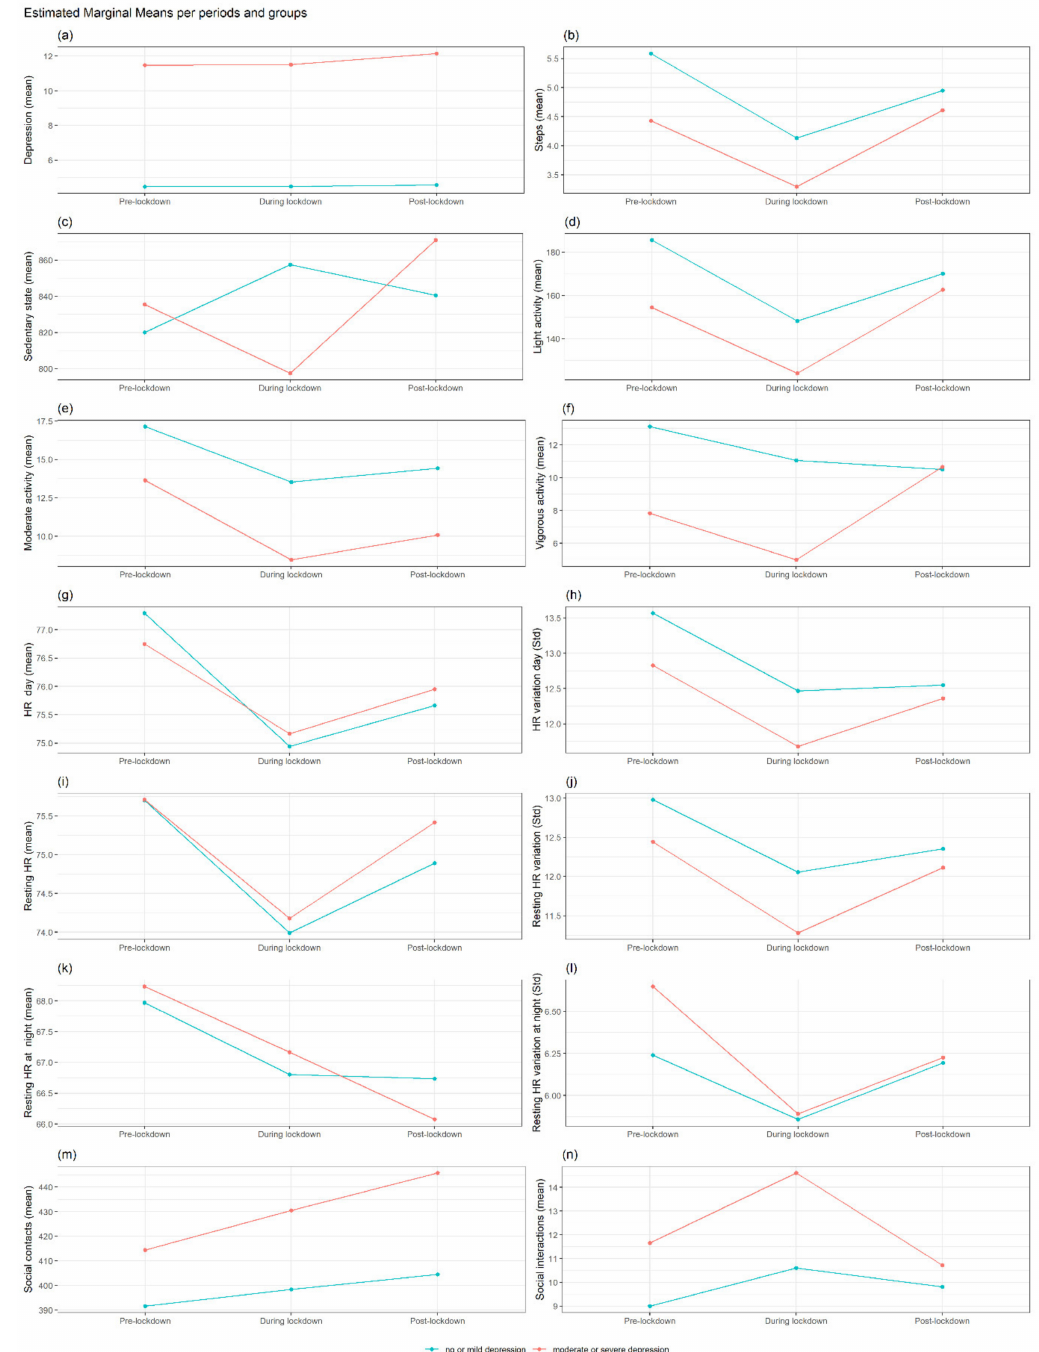
Figure 2. Interaction trajectories by depression status in MS group. Estimated marginal means per MS groups based on depression status (moderate or severe depression versus no or mild depression at baseline) across the three periods (pre, lockdown and post-lockdown) for depression severity ( a ), activity features ( b – f ), HR features ( g – l ), sociality ( m , n ). Note: PHQ-8 = depression severity, Steps = mean steps per day, Sedentary = Number of minutes per day classified as sedentary. Light, moderate and vigorous activity = the number of minutes per day classified as “light”, “moderate” or “vigorous activity”, mHR day = mean heart rate (HR) during 24 h, std HR = standard deviation of HR during 24 h, restingHR day = HR at rest during 24 h, Resting HR at night = HR at rest during the night (0:00–05:59), social contacts = number of contacts in the agenda, social interactions = interactions trough social